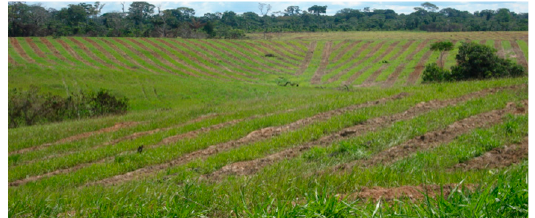
Figure 11. Area prepared for plantation using the “fish spine” variation of soil cultivation.